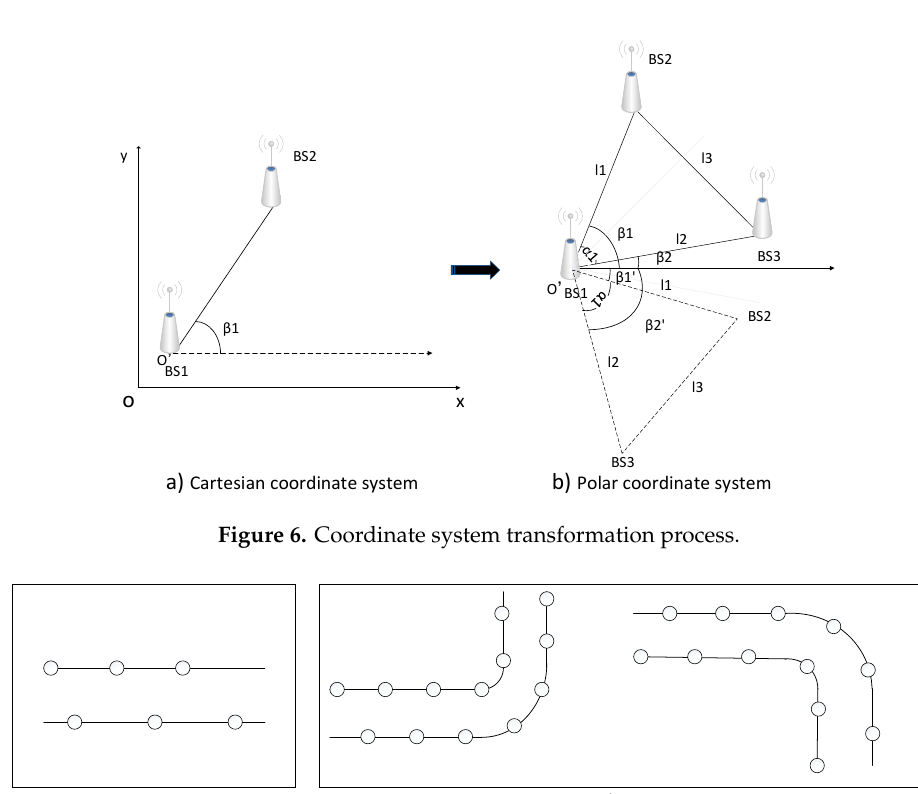
Figure 8. Coordinate transform to estimate virtual triangle unknown vertex.